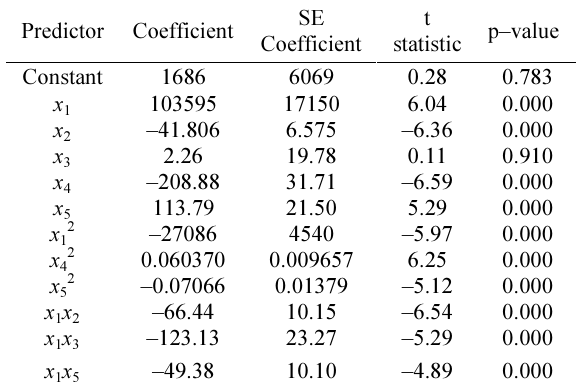
Table 6. Model terms and their significance of the slump